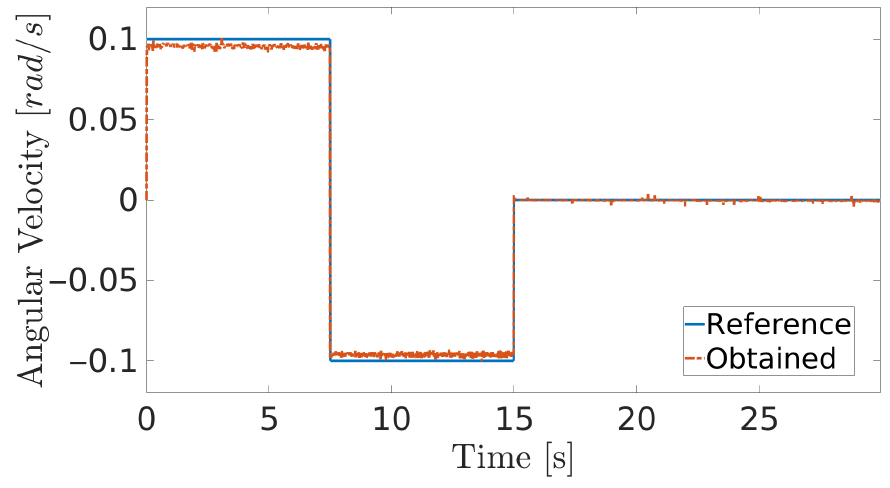
Figure 9. Angular velocity during navigation of the climbing robot in the storage